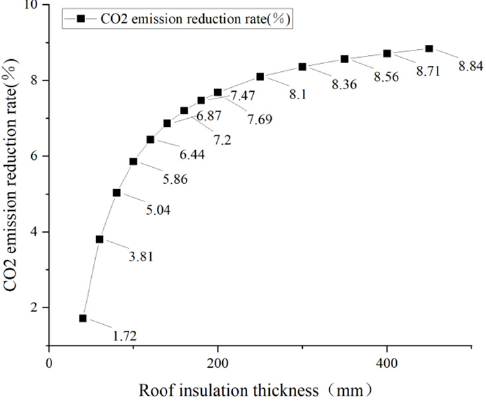
Figure 5. CO 2 emission reduction rate of different roof insulation thicknesses.